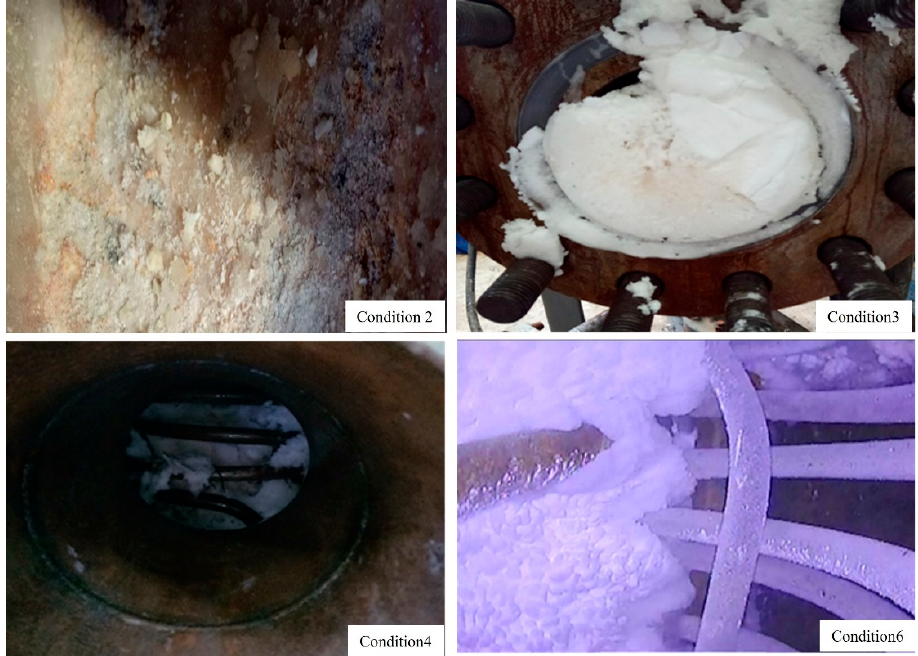
Figure 6. The synthetic products and their distribution and state in the reactor.